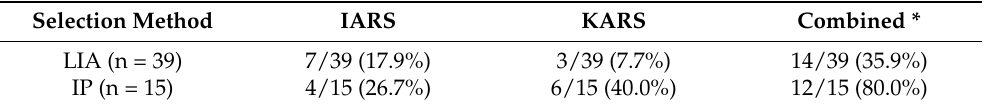
Table 1. Anti-OJ antibodies in samples selected based on a line immunoassay (LIA) or immunopre- cipitation (IP) and measured by PMAT of IARS and KARS peptides.